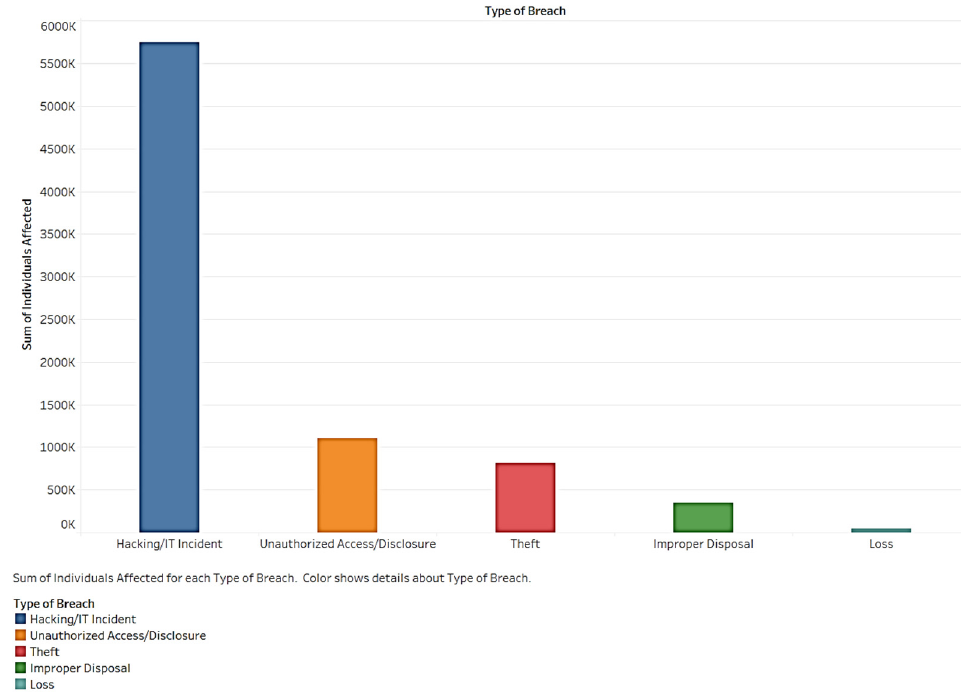
Figure 1. Distribution of breach type and the individuals affected.